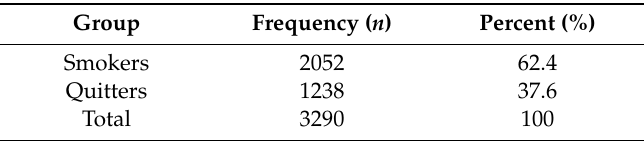
Table 1. Smoking categorization groups.